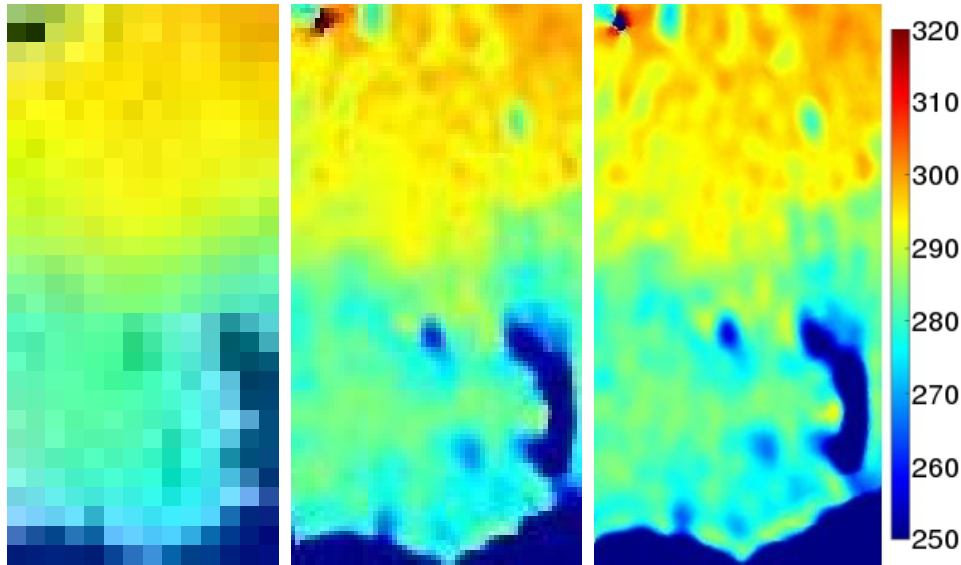
Figure 1. Example SMAP brightness temperature products from a 1050 km by 500 km region of west Africa. The resolution of the images are ( left ) unenhanced (36 km); ( center ) rSIR-enhanced 9 km; and ( right ) rSIR-enhanced 3 km resolution. These data are from day 300 in 2016. As the resolution is made finer, edges become increasingly clear and finer scale patterns become increasingly